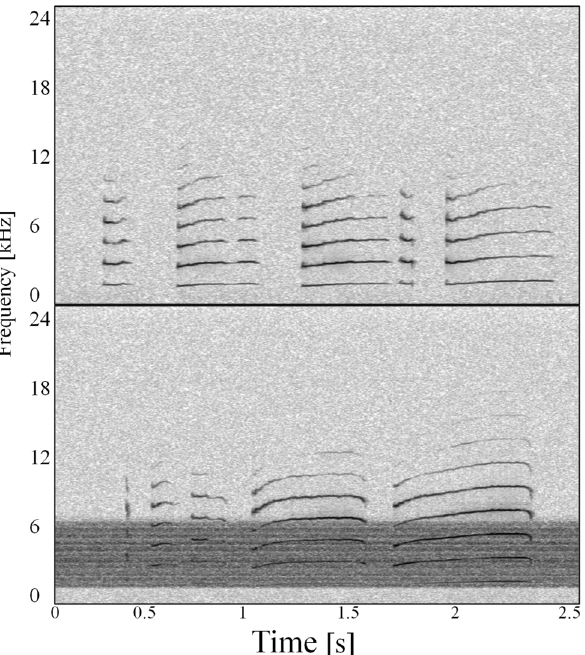
Fig 5. Representative CLCs produced by subject Mulva during a) control and b) treatment A trials illustrating changes to spectral tilt. All whistles from a) have strong fundamental frequencies and maximum energy in the 2 nd harmonic, while in b) the first whistle has a very faint fundamental frequency at approximately 2 kHz, and peak frequencies for all whistles occur in the 4 th harmonics. Reduced energy in the fundamental frequency is also apparent in the second and third whistles (spectrogram parameters: 1024 point Hamming window, 75% overlap, 11.7 Hz frequency resolution).